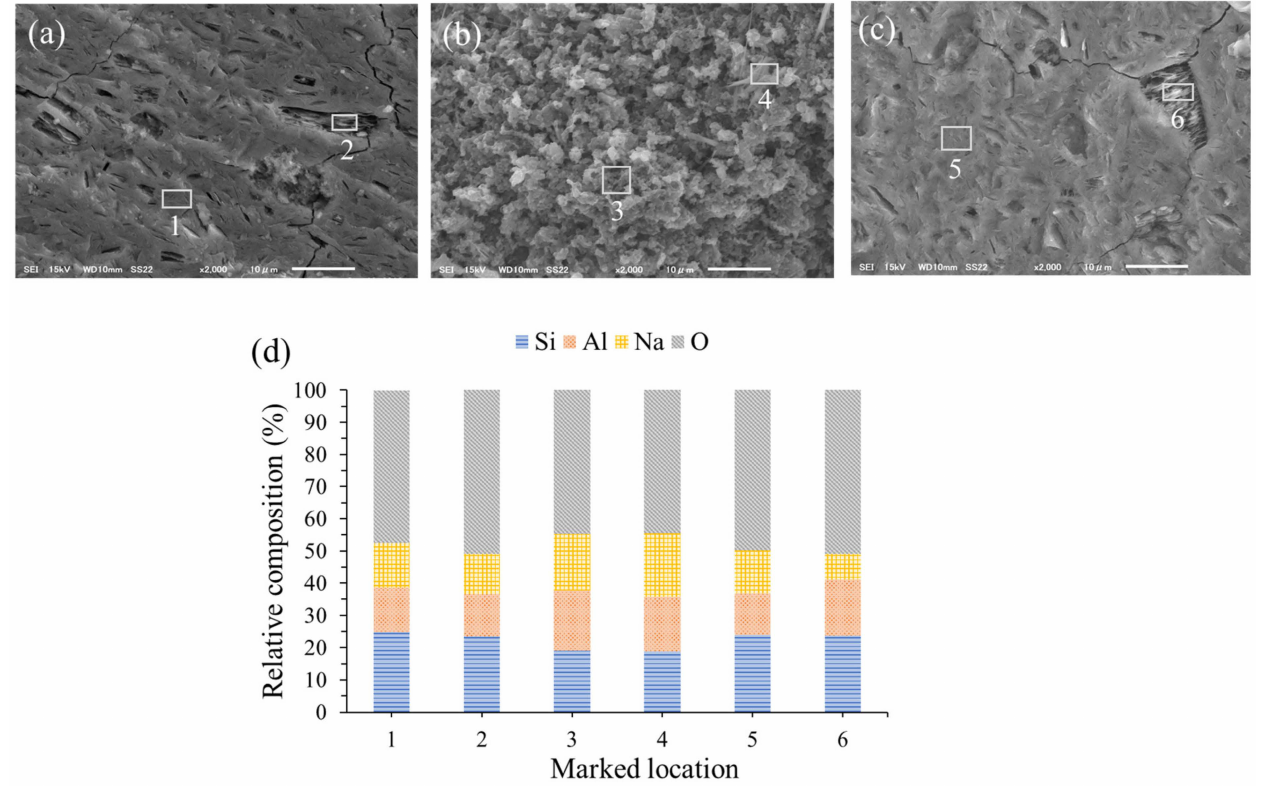
Figure 8. Scanning electron microscopy images of ( a ) the mixed solution-based AAM, ( b ) the NaOH solution-based AAM, ( c ) the Na 2 SiO 3 solution-based AAM, and ( d ) energy dispersive X-ray analysis